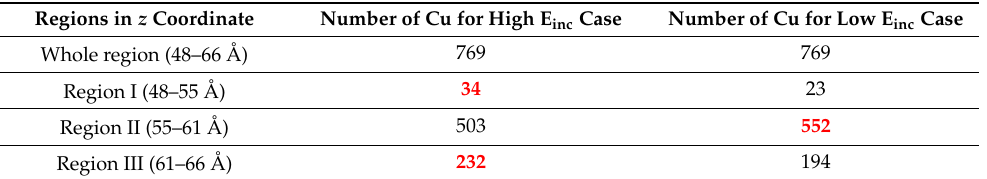
Figure 4. Comparison of 𝑧 position of Cu distribution in CAS between high and low E Inc cases during the stage of IR formation. Region I and III show that there are more Cu for the high E Inc case, whereas region II shows that there are more Cu for the low E Inc case. The difference in Cu numbers between high and low E inc cases is magnified in the inset. Table 1. Comparison of a number of Cu atoms in IR between high and low E inc cases for three regions along the z-direction. Numbers in red font mean that there are more Cu for that E inc case.